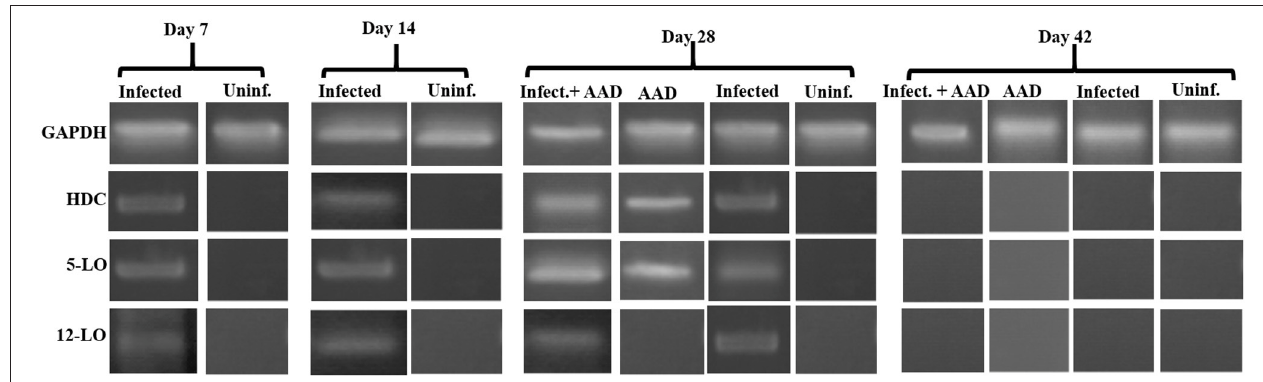
FIGURE 8 | 5-LO, 12-LO, and HDC mRNA expression in mouse lung tissue. Analysis of mouse lung tissue for the mRNA expression of 5-LO, 12-LO, and HDC revealed that only infected groups express 12-LO from days 7 to 28. 5-LO was expressed in both infected groups on days 7 through 28 as well as AAD induced groups (only on day 28). By day 42 there was no expression of any of these genes, reflecting infection clearance and relief from AAD induction.